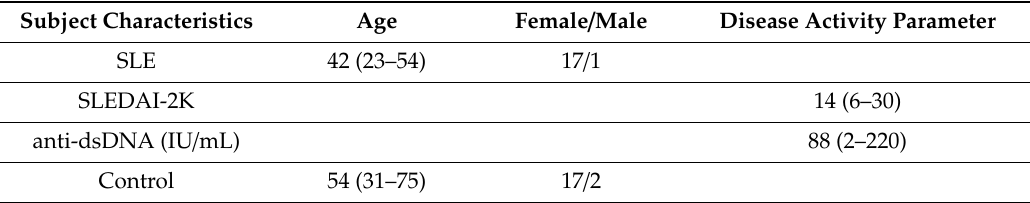
Table 3. Demographics and disease activity parameters. Numbers before and in brackets indicate mean and range, respectively. SLEDAI-2K: SLE Disease Activity-Index-2000, anti-dsDNA: antibody to double-stranded